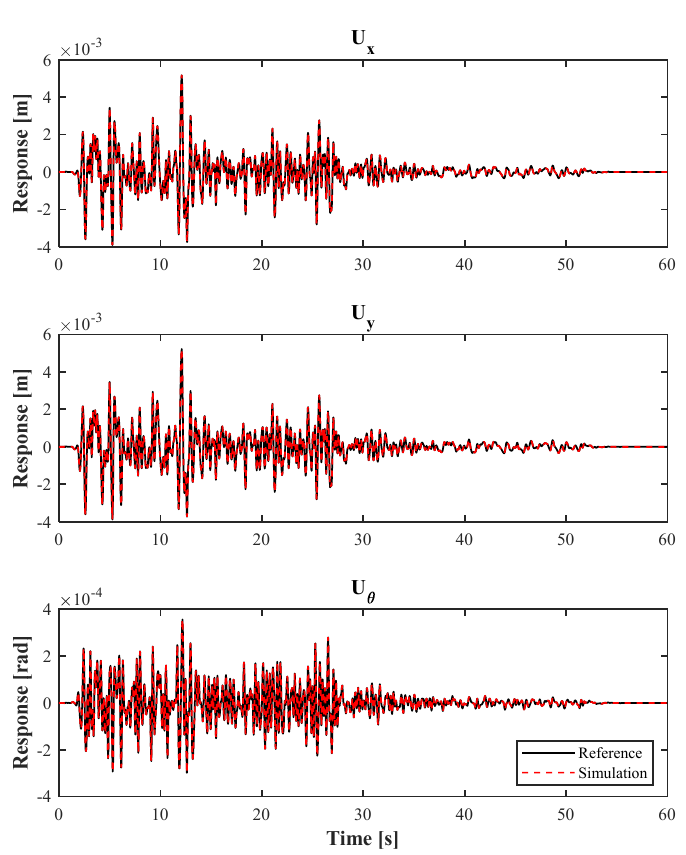
Figure 8. Verification of the simulation for an uncontrolled 10-story building based on Nazarimofrad and Zahrai [34].